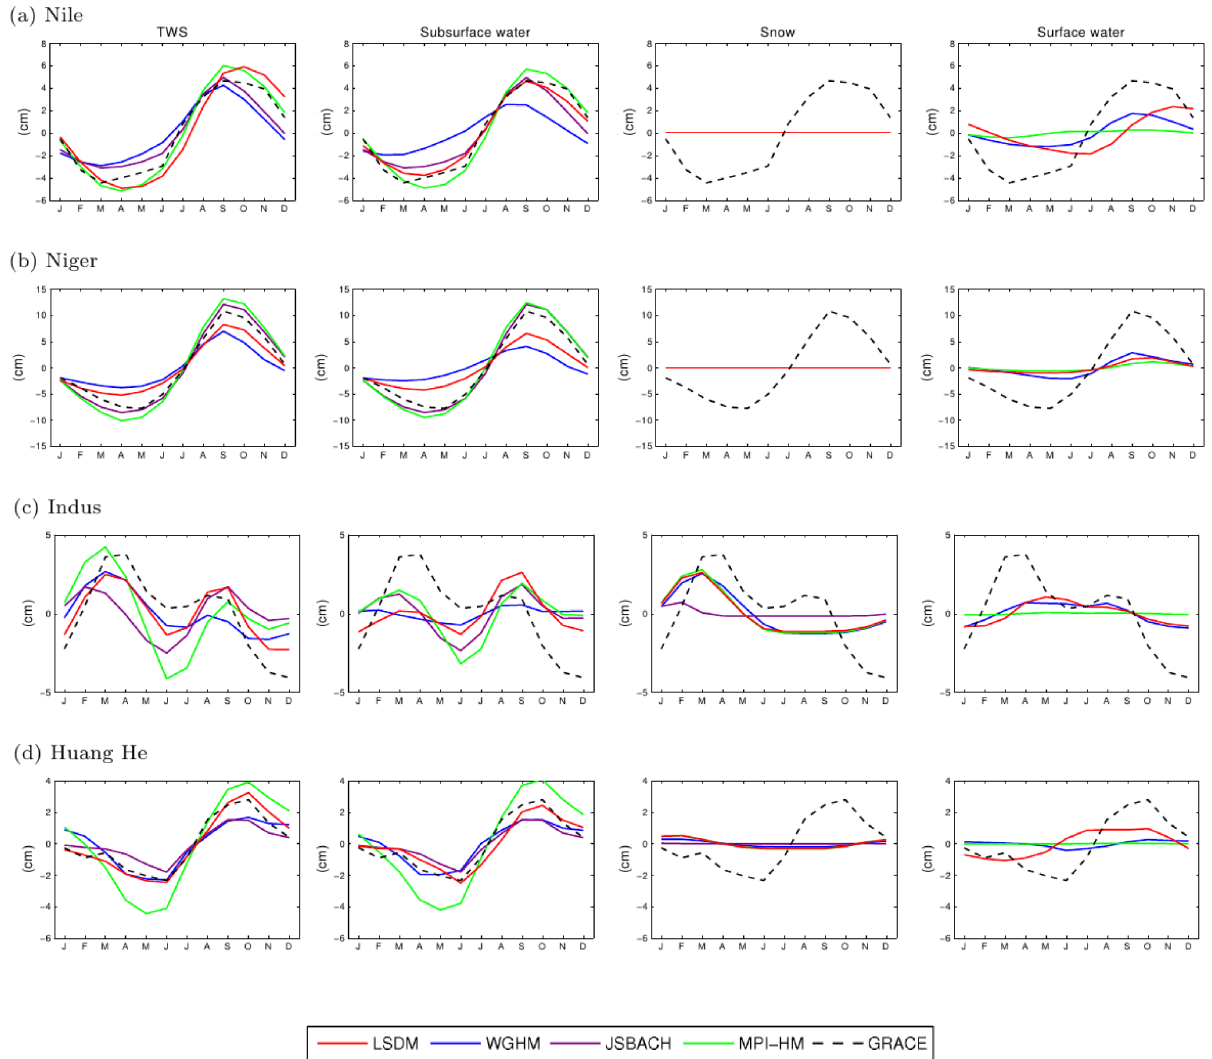
Figure 12. Mean monthly time series of TWS (first column) and the individual storage contributions from subsurface water (second column), snow water equivalent (third column) and surface water (fourth column), each for four dry catchments: Nile, Niger, Indus and Huang He. TWS from GRACE (black line) has been included in every sub-figure for